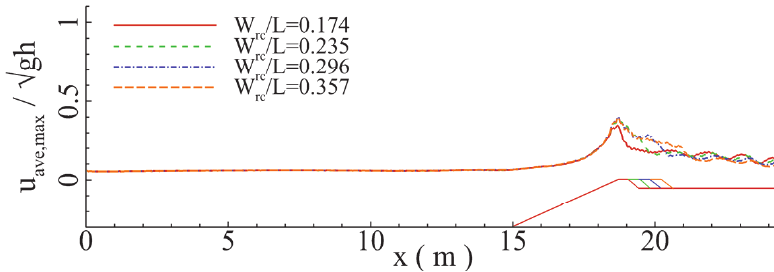
Figure 58. Space distribution of the local maximum depth-averaged velocity.